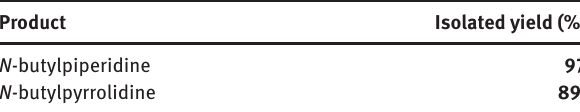
Table 7: Isolated yield of N -butylpiperidine and N -butylpyrrolidine.